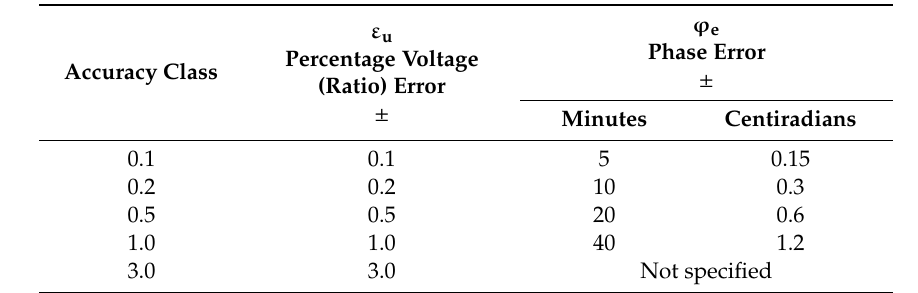
Table 3. Metering class accuracy requirements